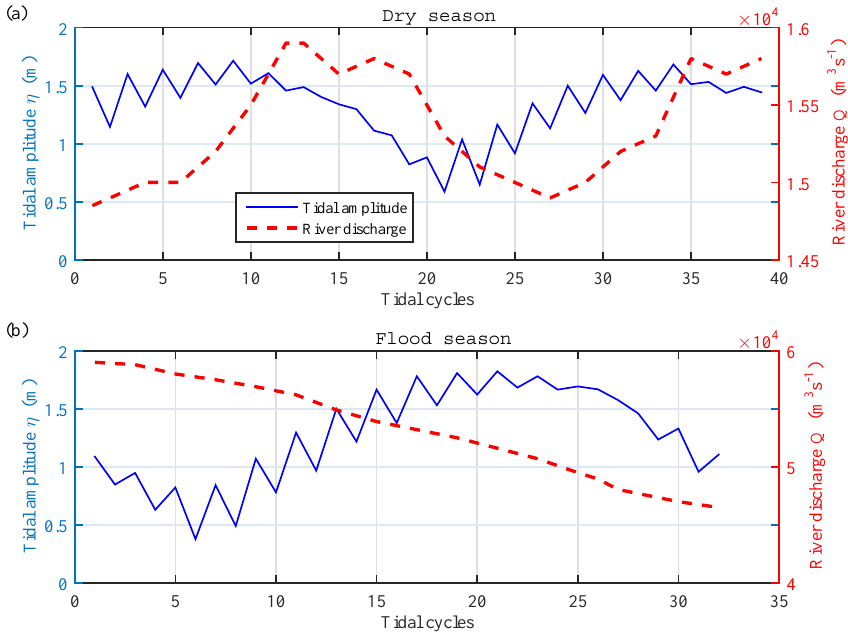
Figure 8. Observations of tidal amplitude at the estuary mouth (Hengsha station) and fresh water discharge at the upstream boundary (Datong station) during the dry (a) and flood (b)